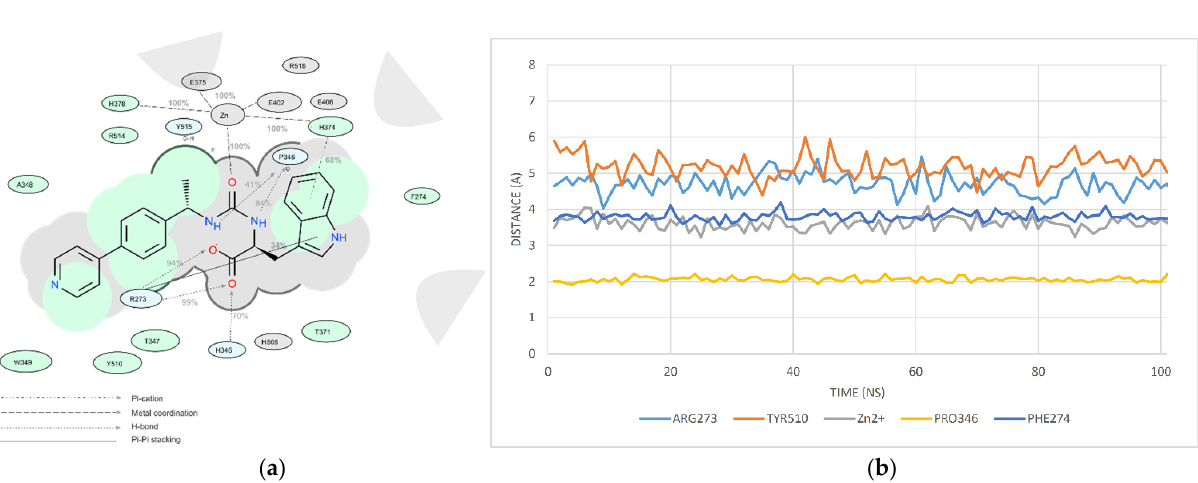
Figure 13. A detailed interaction scheme of ligand atoms (Z2396153450) with protein residues: ( a ) generalized graphical representation of the interactions and contacts (H-bonds, hydrophobic, ionic, water bridges); ( b ) scheme showing the distance evolution (in Å) between the ligand and residues.